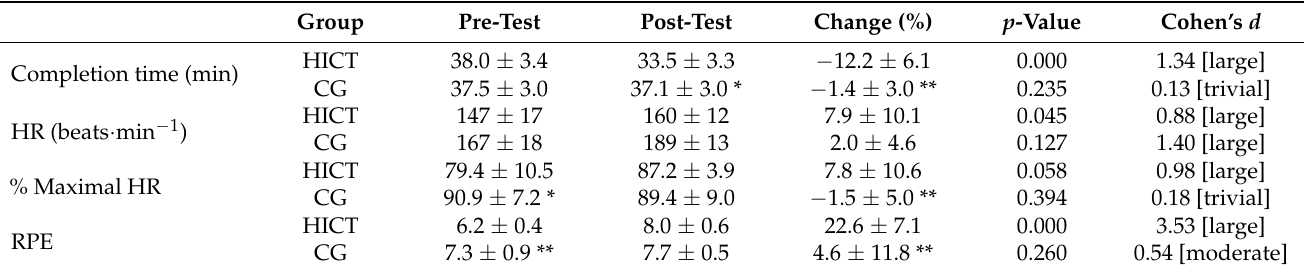
Table 4. Mean performance, physiological and perceptual responses during the Pack test (mean ± SD